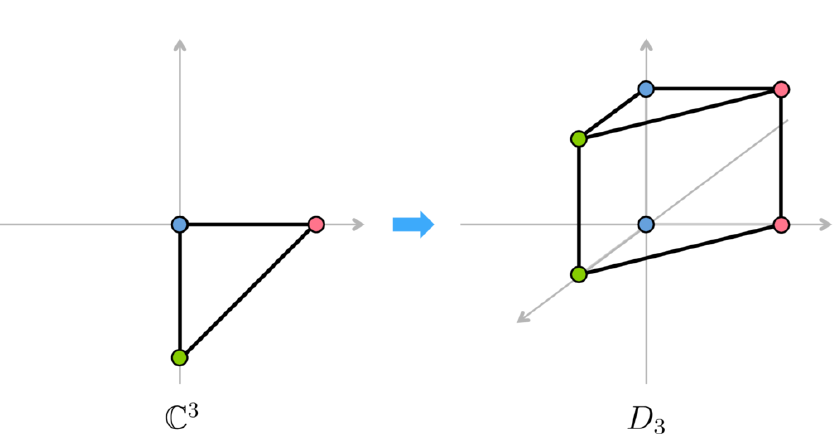
Figure 10. The toric diagram for D 3 , obtained by lifting three perfect matchings of C 3 .